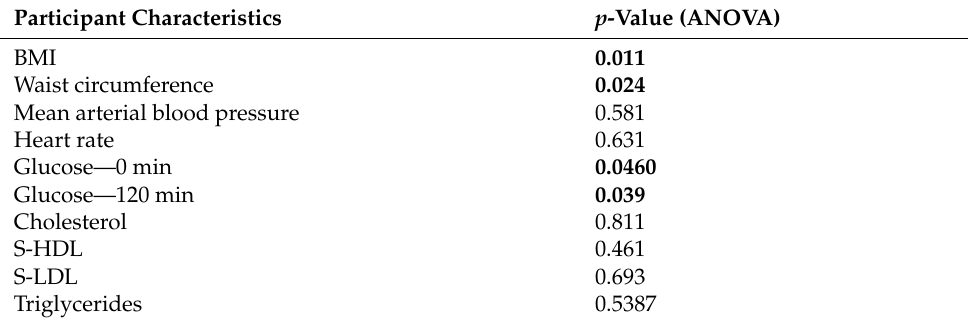
Table 3. p -values for interactions between group and time for clinical and laboratory measurements. Statistically significant p -values are marked in